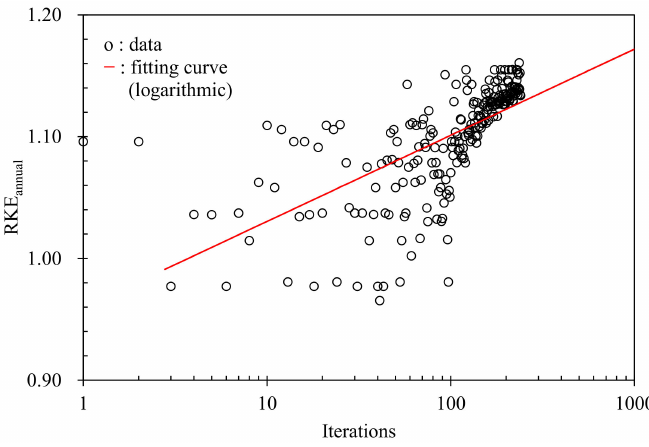
Figure 8. Evolutionary changes in RKE annual .